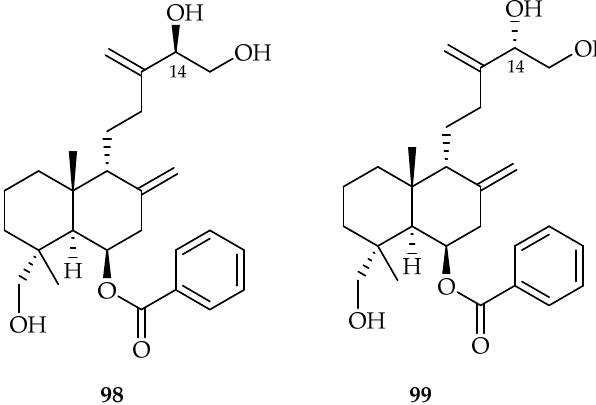
Figure 40. Structure of scoparicols C 98 and D 99 [62].